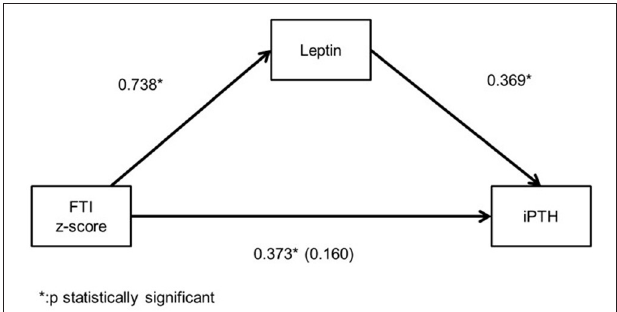
FIGURE 2 | Mediation analysis illustrating the spearman’s correlation coefficient between serum leptin, intact parathormone (iPTH) levels and fat tissue index (FTI) z-score and the partial spearman’s correlation efficient (in parenthesis) between iPTH and FTI z-score after adjustment for serum leptin in chronic kidney disease (CKD) stage 3